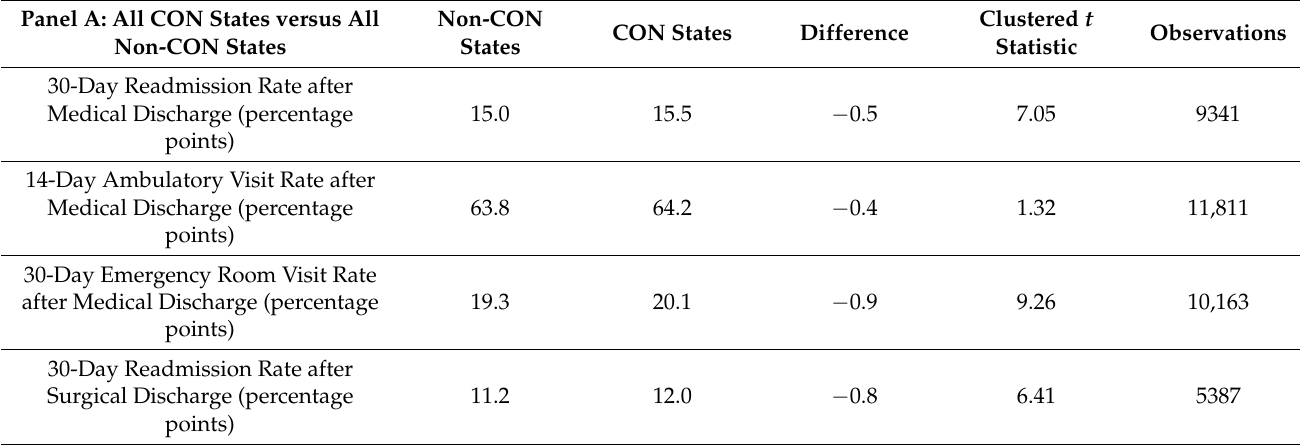
Table 11. Difference-in-means tests: aggregate quality